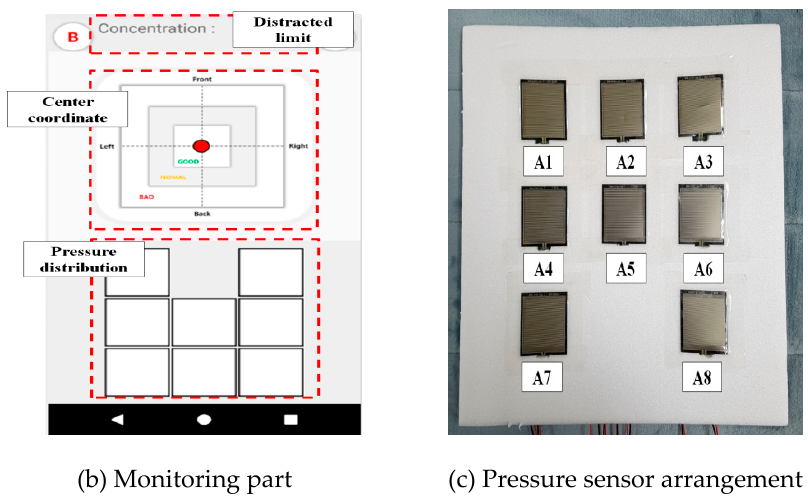
Figure 6. Implemented distraction estimation system.